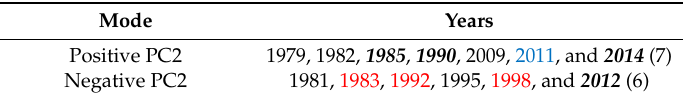
Table 4. Composite years of the positively and negatively extreme PC2 years within the 41-year period (1975–2015). Refer to the manuscript for the definitions of the composite years and the drought years. The number of years is indicated in parentheses. Bold and italics indicate winter drought years. Red and blue colors refer El Niño and La Niña winters,